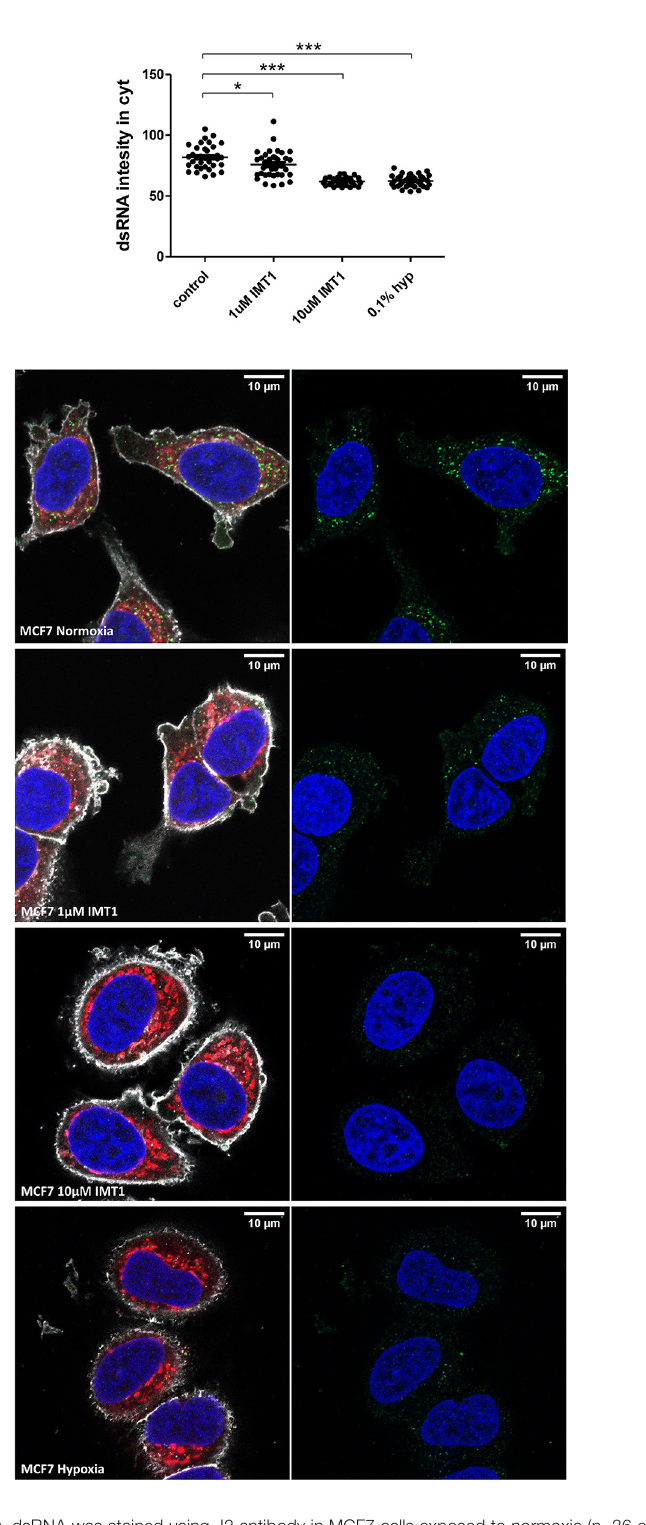
Frontiers in Oncology |